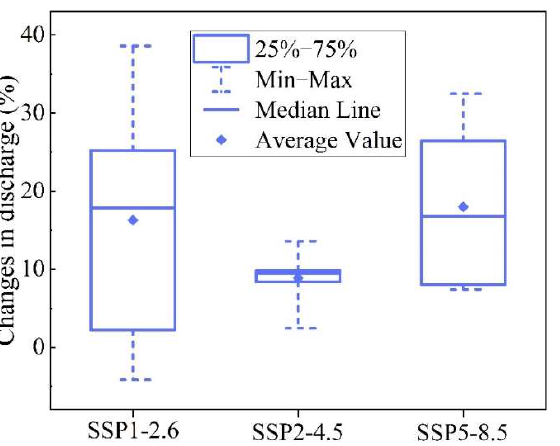
Figure 11. A box−plot of discharge changes in 6 GCMs relative to baseline period under the SSP1-2.6, SSP2-4.5, and SSP5-8.5 emission scenarios.